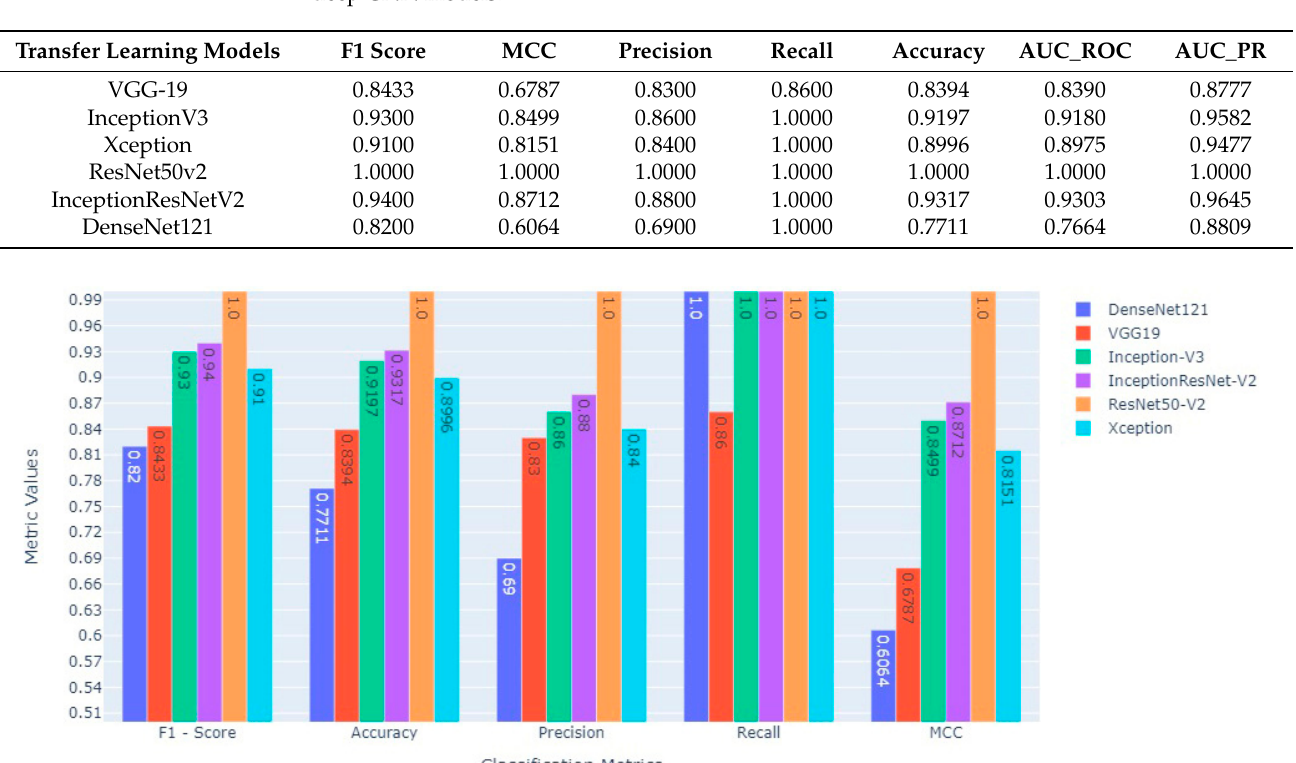
Table 6. Comparison of different performance evaluators between the six pre-trained transfer learning deep CNN models.